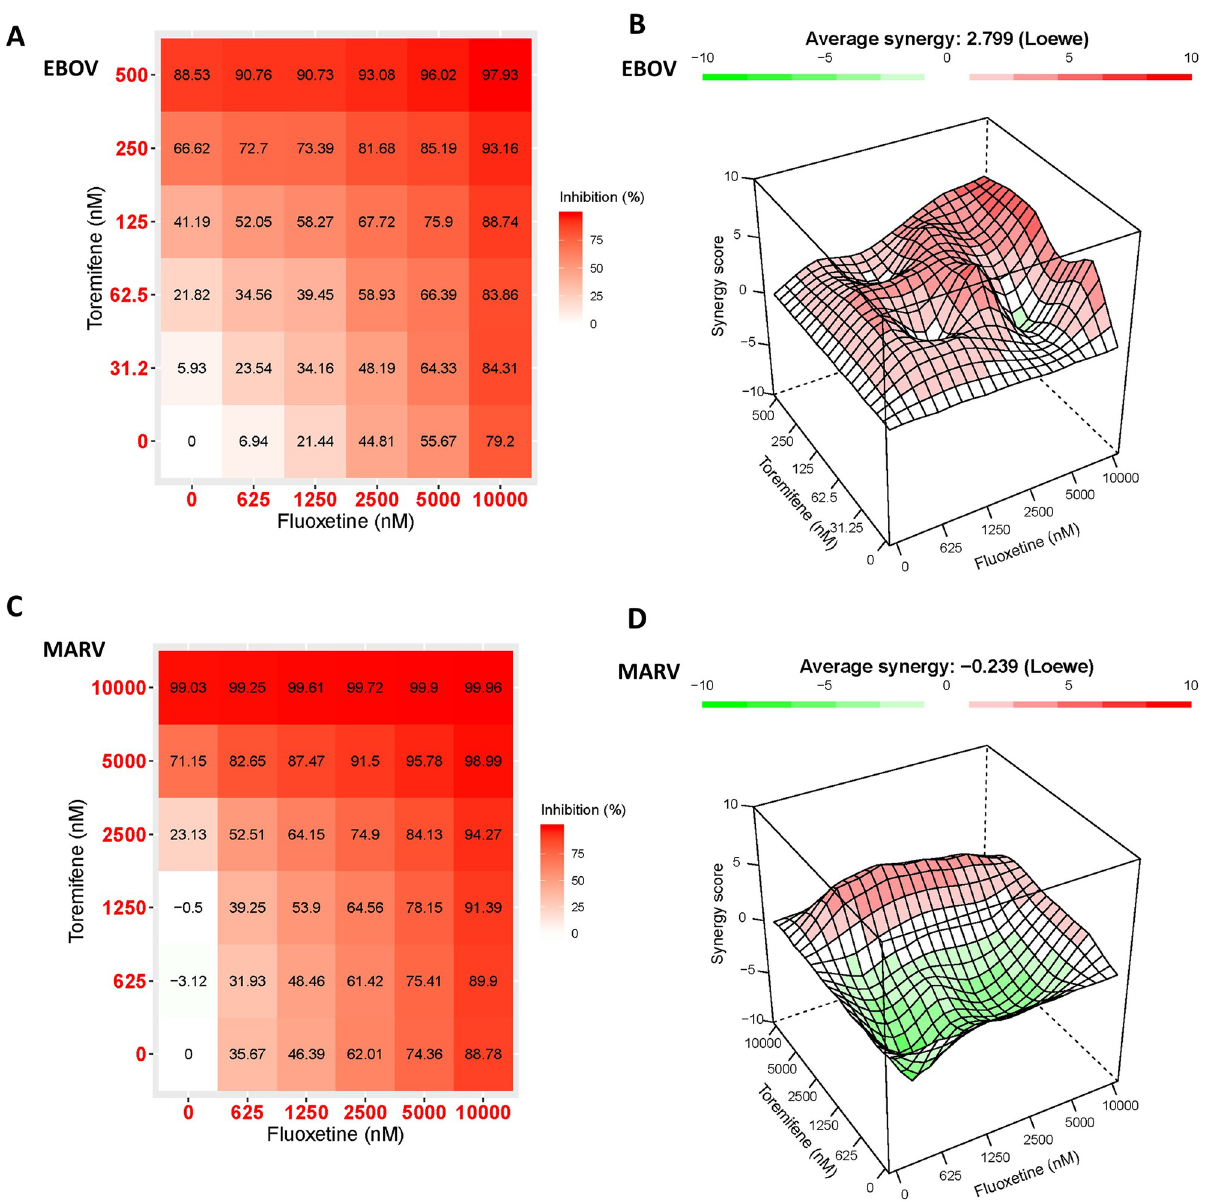
Fig 6. Toremifene and fluoxetine show synergism against pseudotyped WT-EBOV but not WT-MARV. (A) Dose-dependent response of 6 x 6 concentration matrix of toremifene and fluoxetine combination in pseudotyped WT-EBOV and 3D synergism score plot (B) using Loewe’s additive model. Synergy score means % over expected additive effect; (C) Dose-dependent response of 6 x 6 concentration matrix of toremifene and fluoxetine combination in pseudotyped wild-type Marburg virus and3D synergism score plot (D) using Loewe’s additive model. Data was collected and averaged from three individual biological